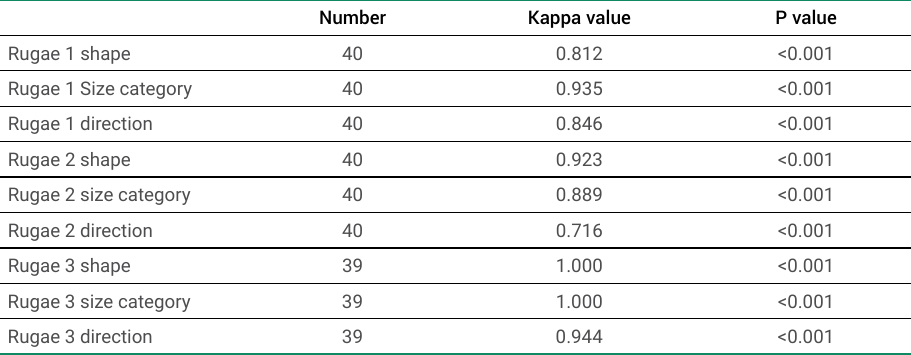
Table 2. Kappa values for intra-examiner